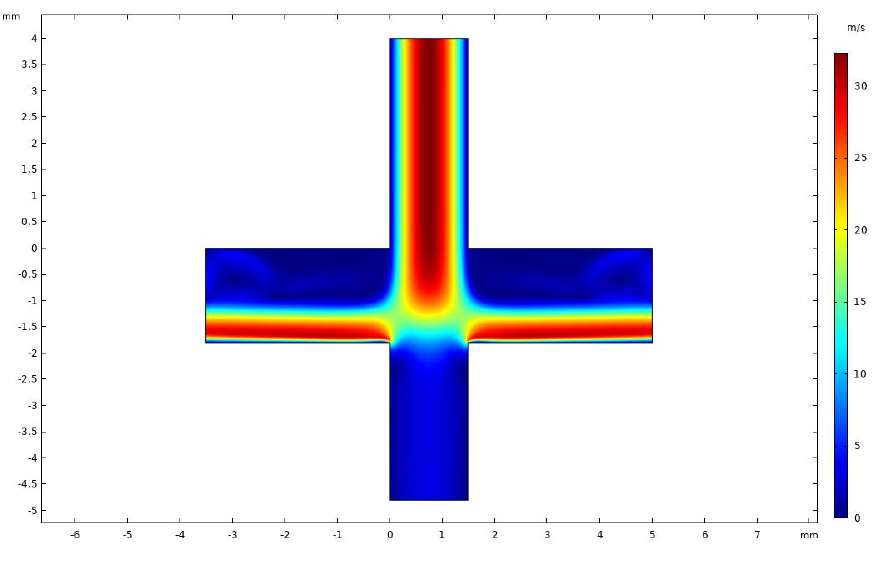
Figure 5. Velocity distribution in VI.